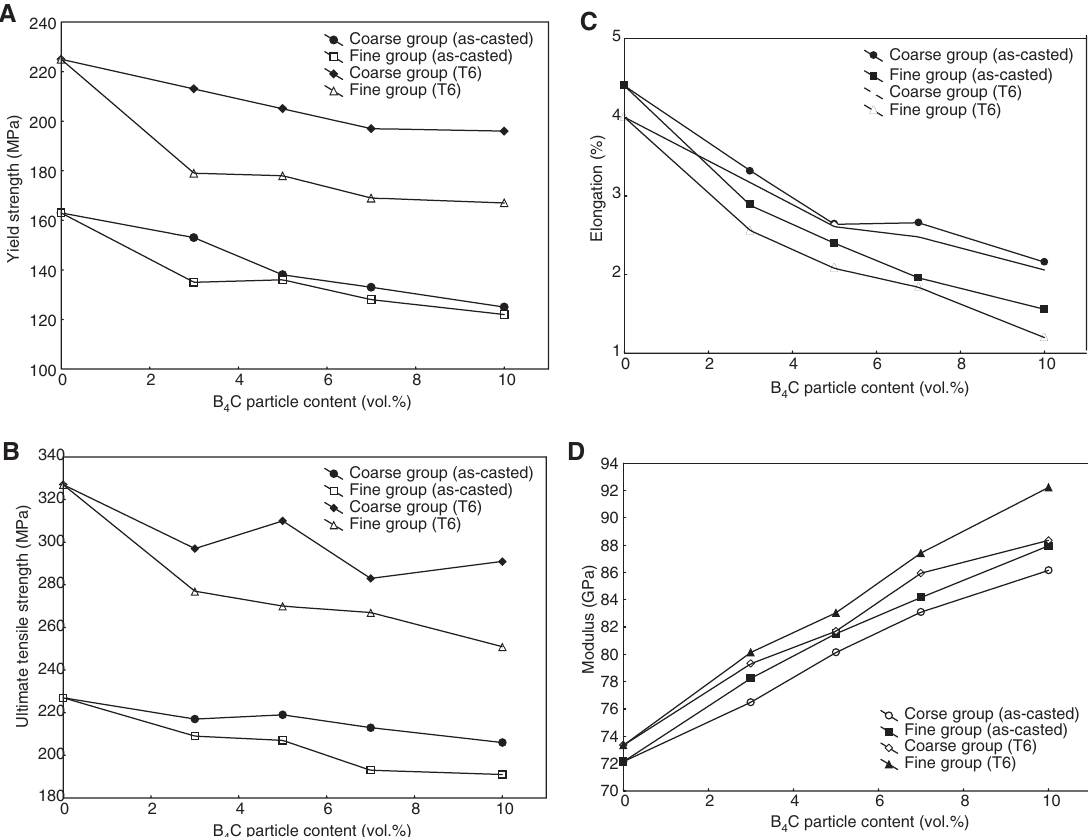
C content and size in the as-casted and T6 condi- 4